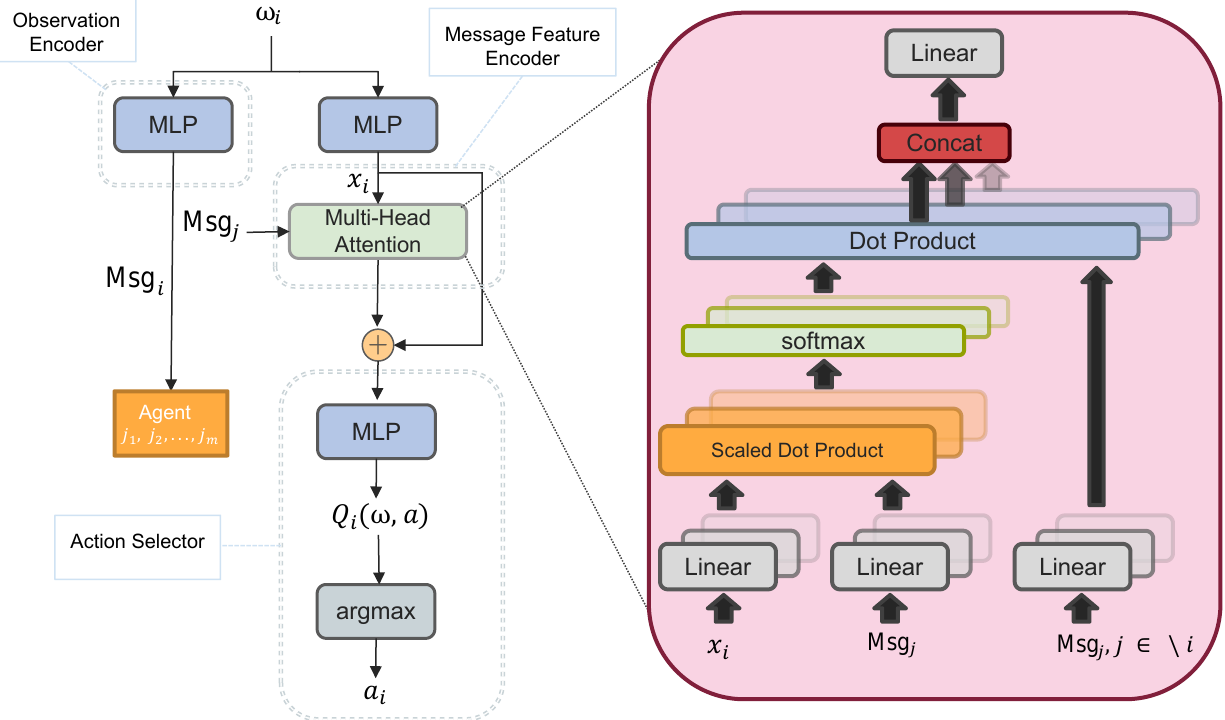
Figure 1. Network architecture for agent i . The observation encoder on the left encodes observation ω i to Msg and broadcasts it. The right part shows how policy network receives the messages from i other agents and aggregates them with ω i by the multi-head attention